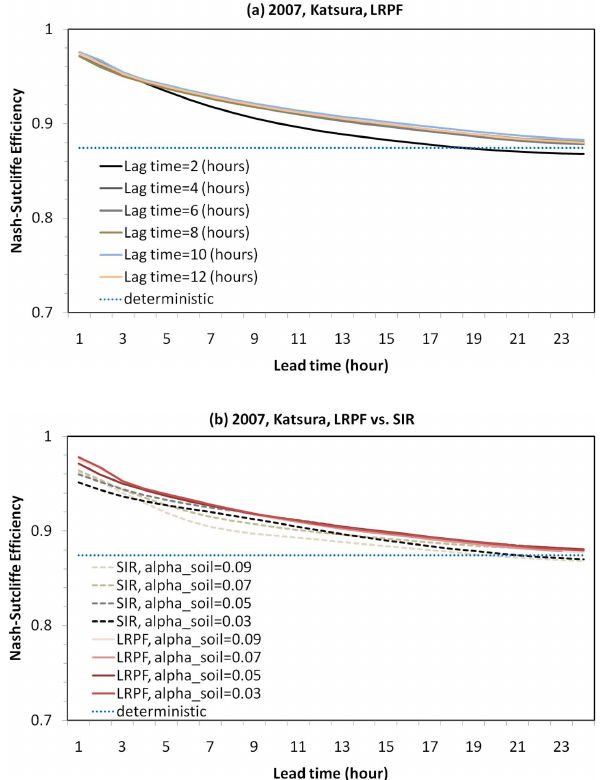
Fig. 12. Nash-Sutcliffe model efficiency for varying parameter val- ues of the process error variance, α soil . The red lines represent the lagged regularized particle filter. The dashed lines represent the SIR particle filter. A dotted line represents a deterministic modelling